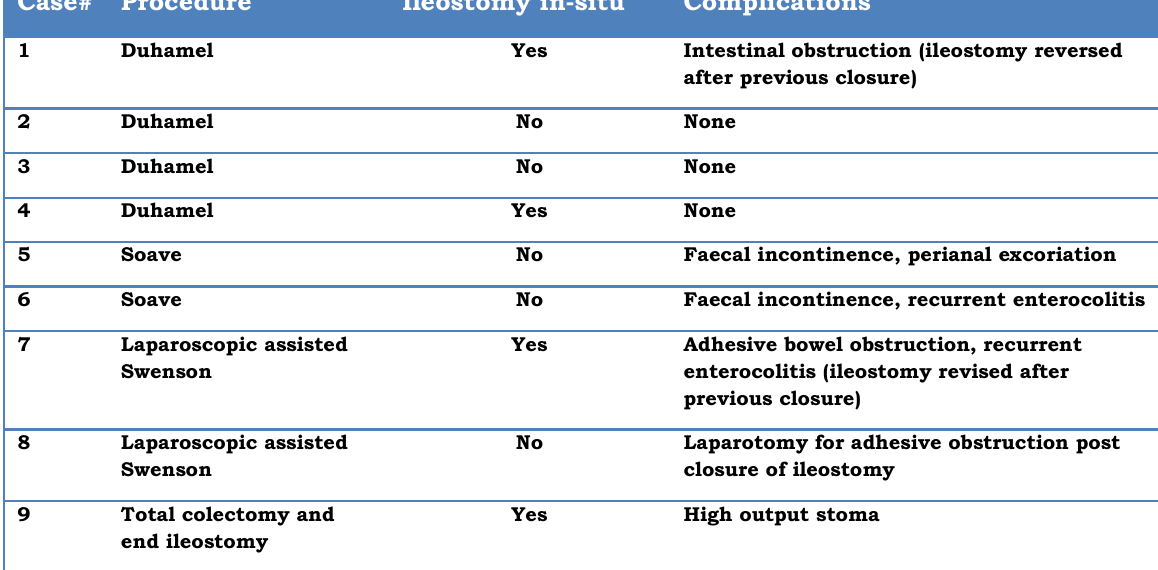
Table 3: Outcomes in relation to definitive procedures for all cases of total colonic aganglionosis (TCA)